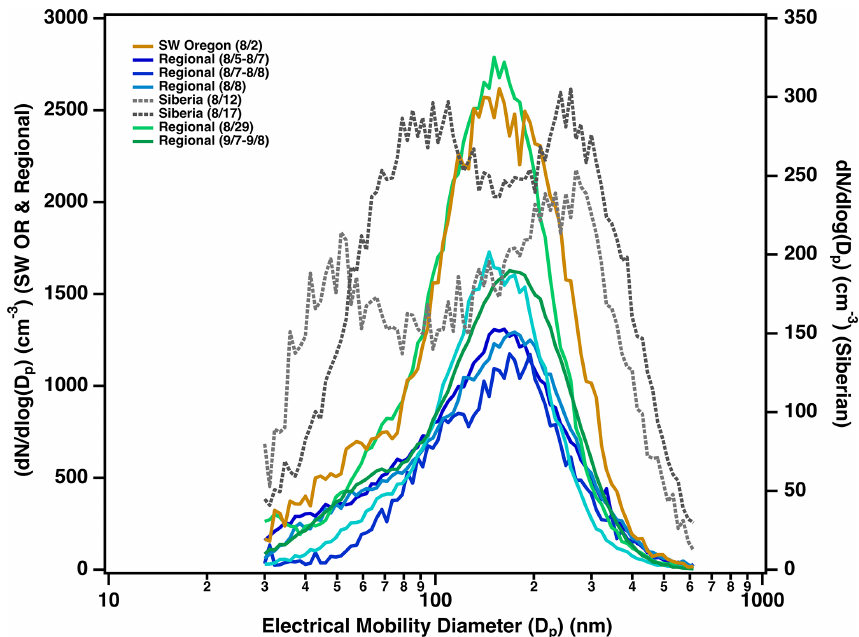
Figure 6. Event-averaged aerosol number size distributions in d N/ dlog( D p ) measured by SMPS for the SW OR (left axis), regional (left axis), and Siberian (right axis) BB events identified in August–September 2019 at MBO as well as the background average aerosol number size distribution (right